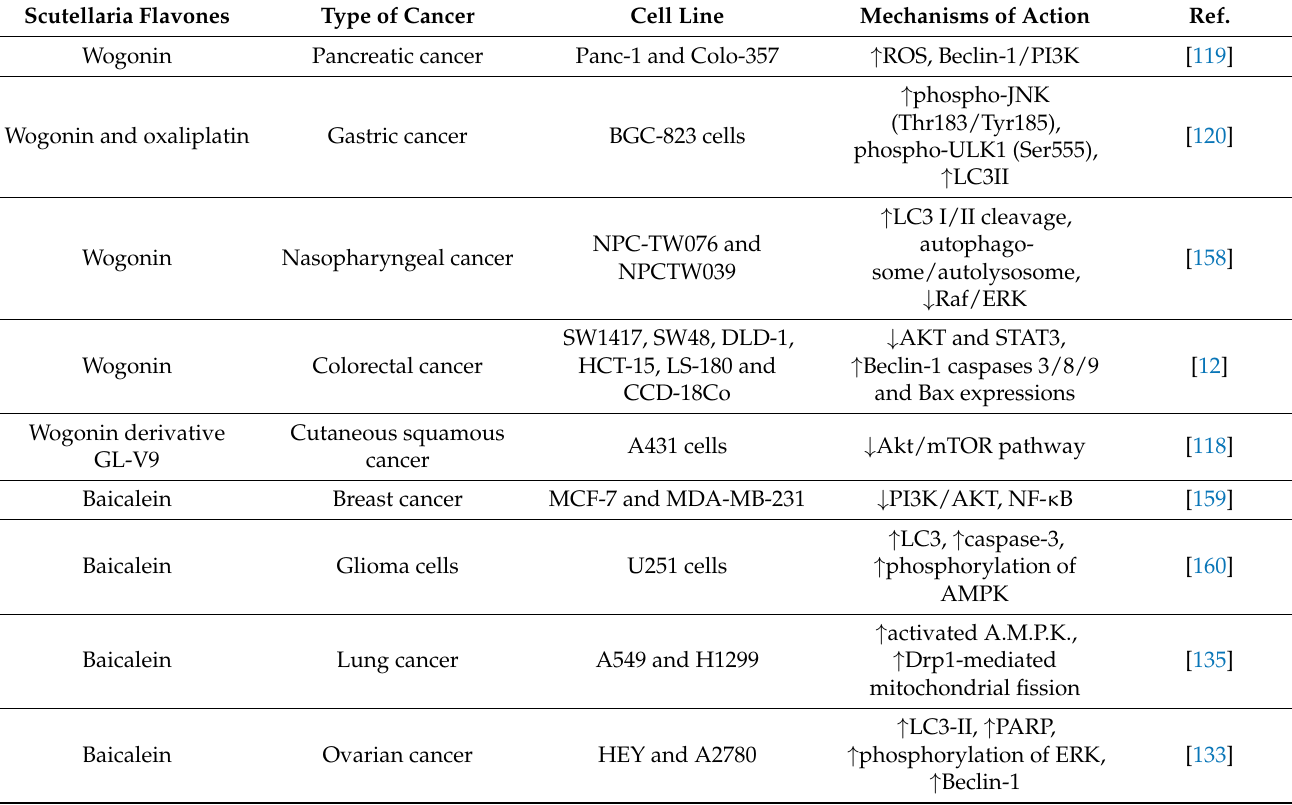
Table 3. Regulation of autophagic machinery by Scutellaria flavones in different cancer